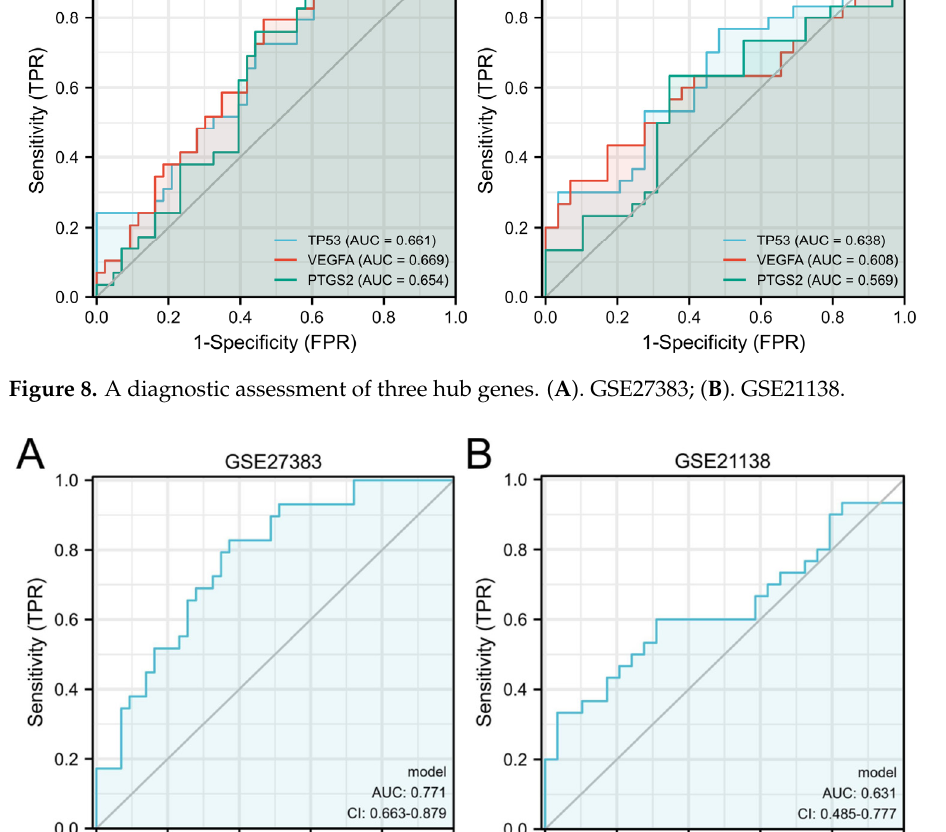
Figure 7. Expression of TP53, VEGFA and PTGS2 in brain tissue ( P < 0.05). After that, the diagnostic value of the above three hub genes was verified by using the ROC curve. As separate diagnostic indicators, the results are shown in Figure 8. When the three hub genes are used as joint indicators, the outcomes are displayed in Figure 9.